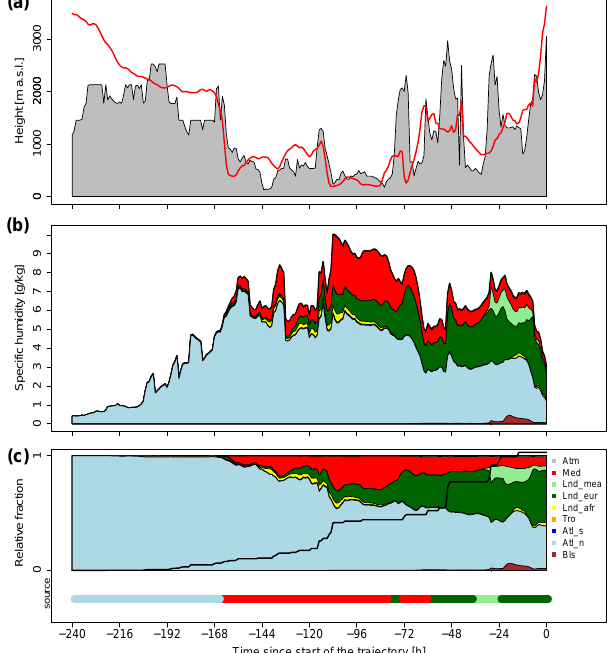
Figure 12. Moisture source analysis along a 10-day trajectory mov- ing from the Atlantic to eastern Europe (trajectory A in Fig. 11). (a) Trajectory height (red, in m) and scaled boundary layer height (grey shading, in m). (b) Specific humidity (in gkg − 1 ) along the trajectory decomposed into the different moisture sources of the tagging experiment (see Fig. 4). (c) Relative contributions of the tracers to the specific humidity (shading) and accounted fraction of the Lagrangian diagnostics (black line). The coloured thick line in the lower part indicates the source areas corresponding to the actual position of the air